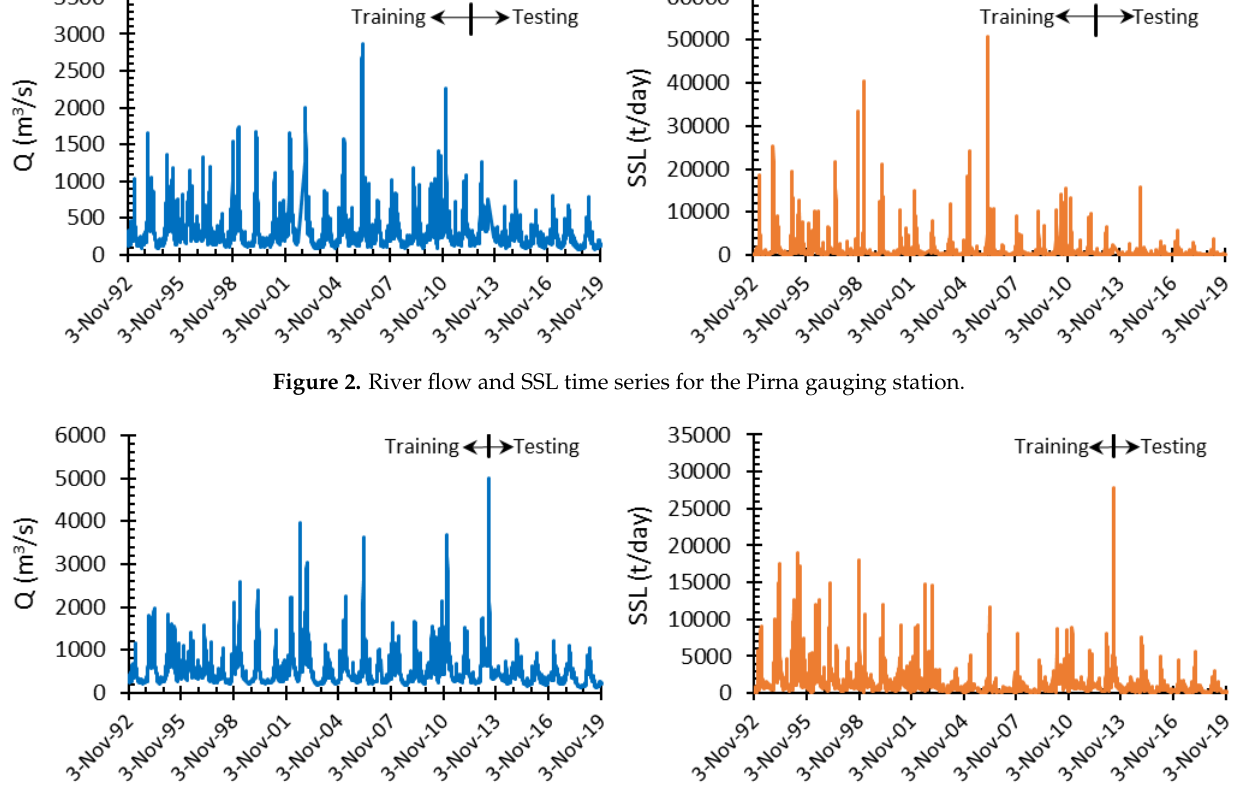
Figure 3. River flow and SSL time series for the Magdeburg-Strombrücke gauging station.